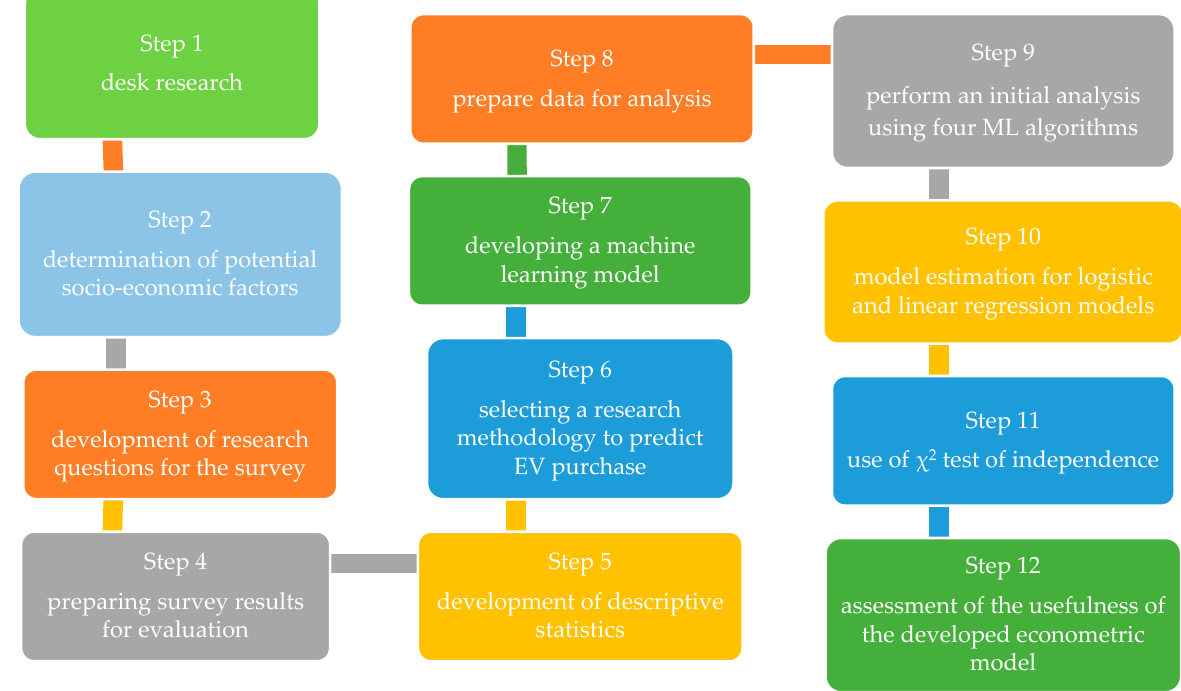
Figure 3. Multi-step research approach.